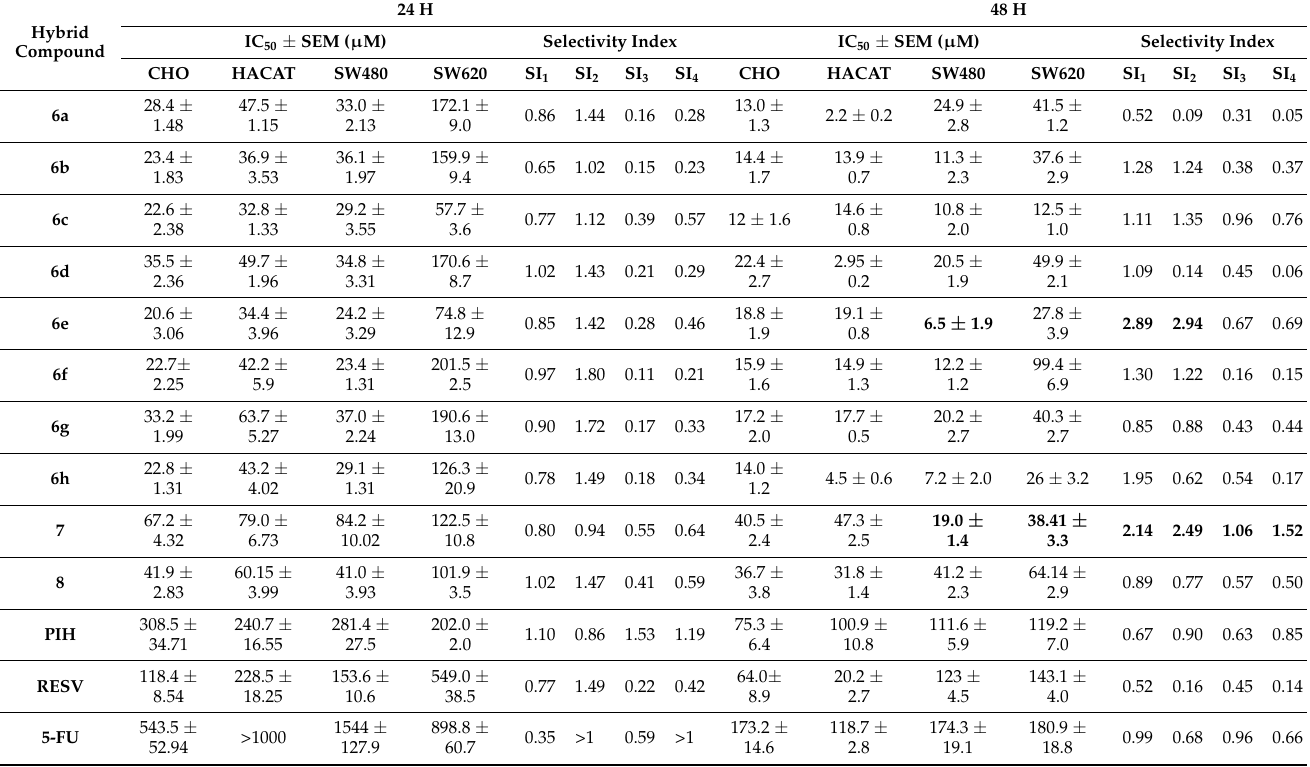
Table 1. Cytotoxic effect of resveratrol/hydrazone hybrids on SW480, SW620, HaCaT and CHO-K1 cell